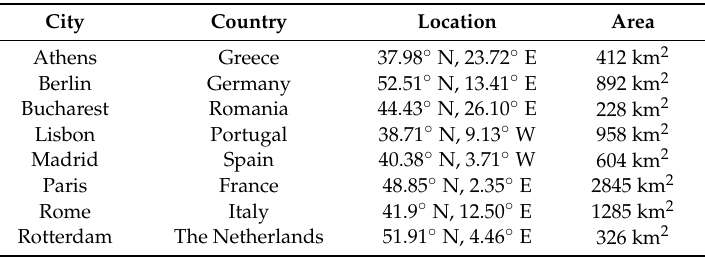
Table 1. Information about the selected